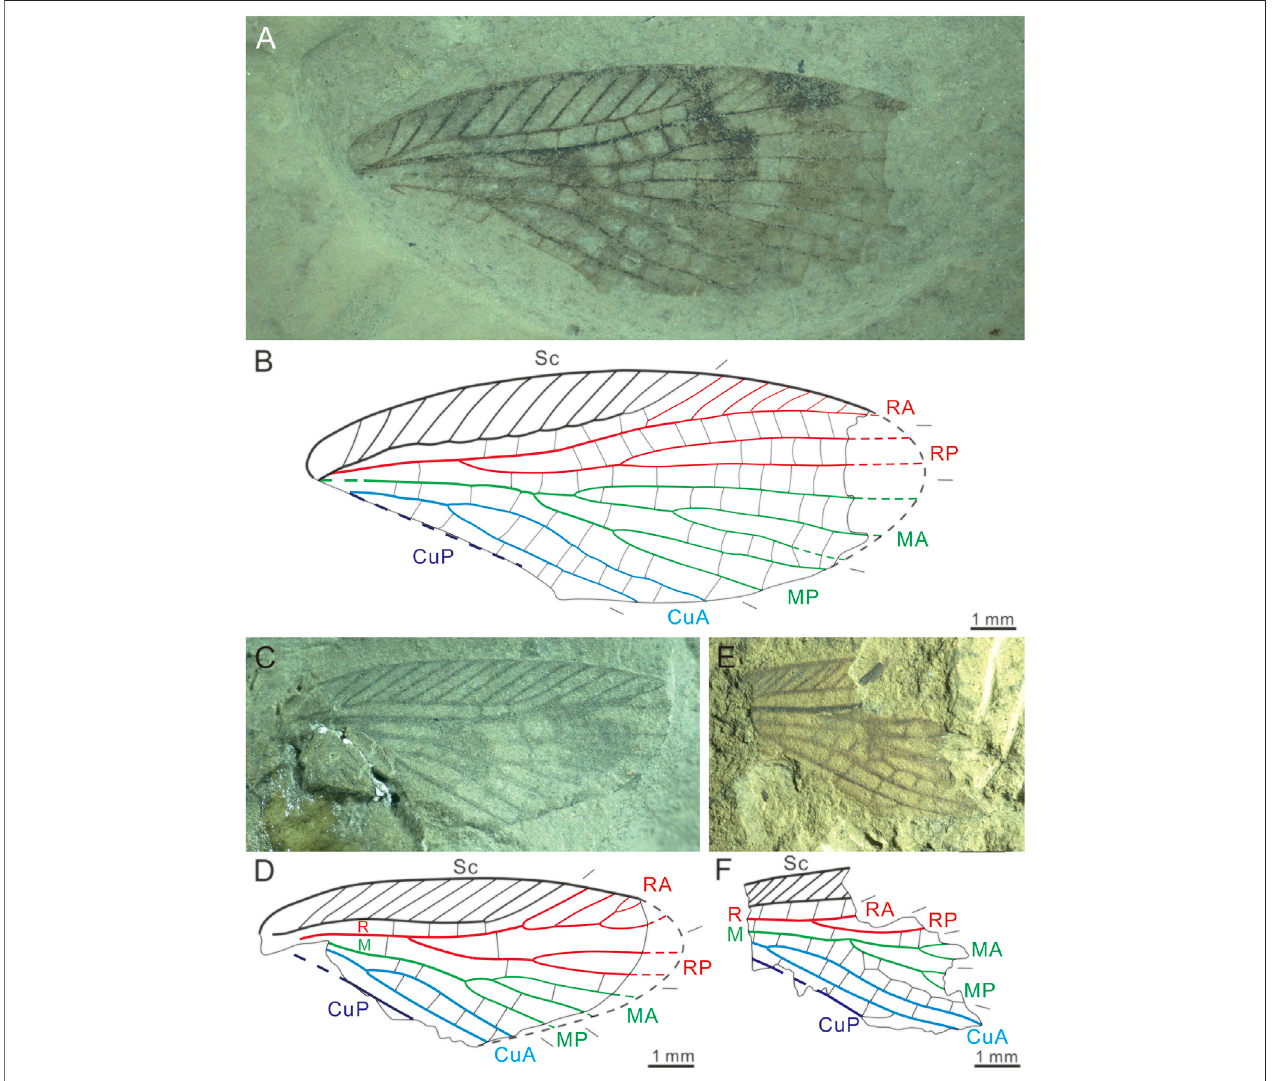
FIGURE 2 | (A) Reversed photograph of Chauliodites tongchuanensis sp. nov. Holotype, NIGP162048a; (B) venational interpretation of (A) ; (C) reversed photograph of Chauliodites nanshenghuensis (Lin, 1978) comb. nov., Holotype, NIGP51620; (D) venational interpretation of (C) ; (E) photograph of Chauliodites fuyuanensis (Lin, 1978) Aristov, 2004, holotype, NIGP51619; (F) venational interpretation of (E)